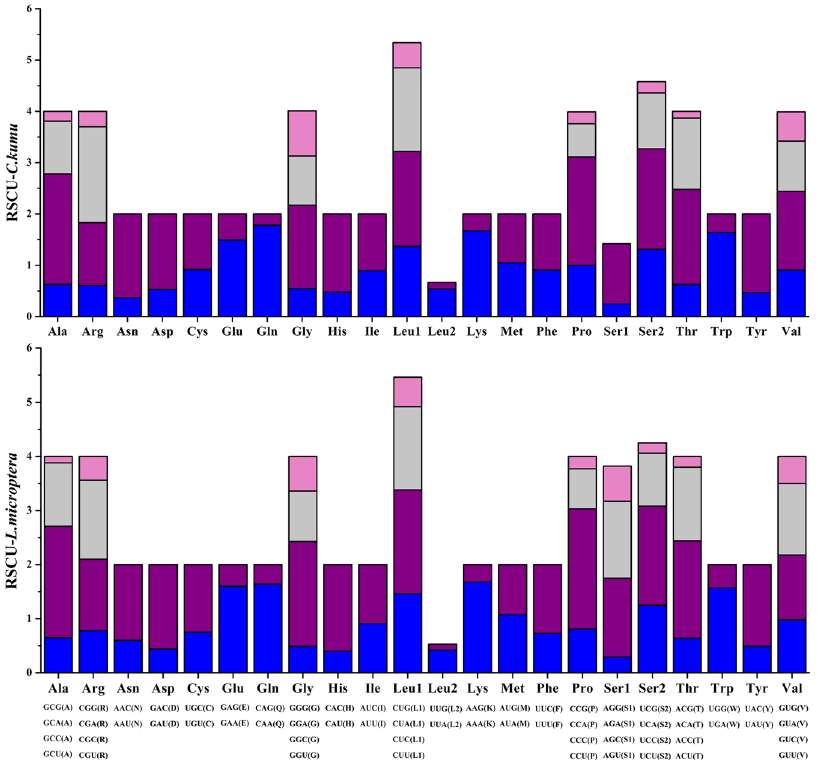
Figure 2. The relative synonymous codon usage (RSCU) in the mitogenomes of C. kumu and L. microptera .